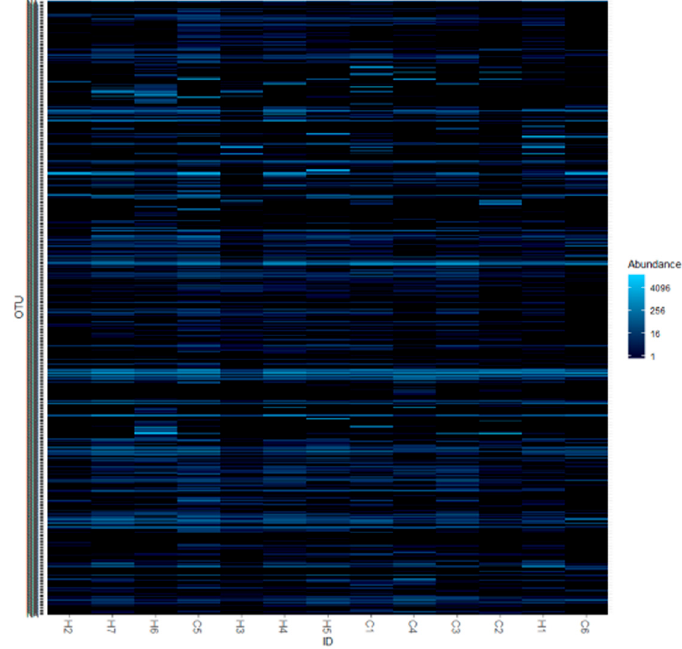
Figure 2. Heat map constructed from whole reads from 13 subjects.